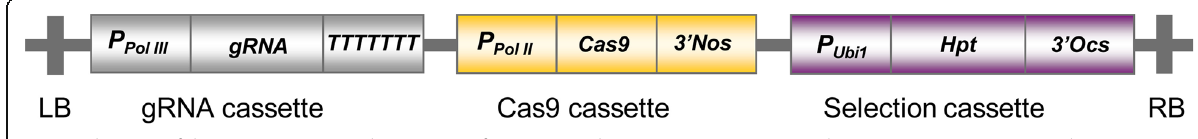
Fig. 1 Schematic of the T-DNA region in a binary vector for genome editing in monocots. P Pol III : Polymerase III promoter. P Pol II : Polymerase II promoter. P Ubi1 : maize Ubiquitin 1 promoter and the first exon. Hpt : Hygromycin phosphotransferase . (Modified from Howells et al.